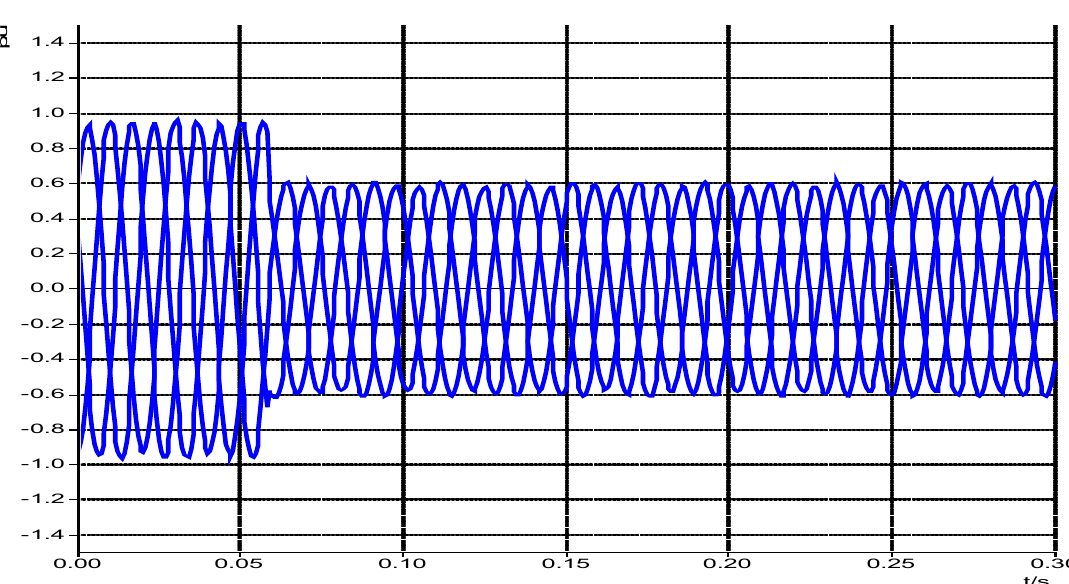
Figure 21. Instantaneous value of the main voltage U grid